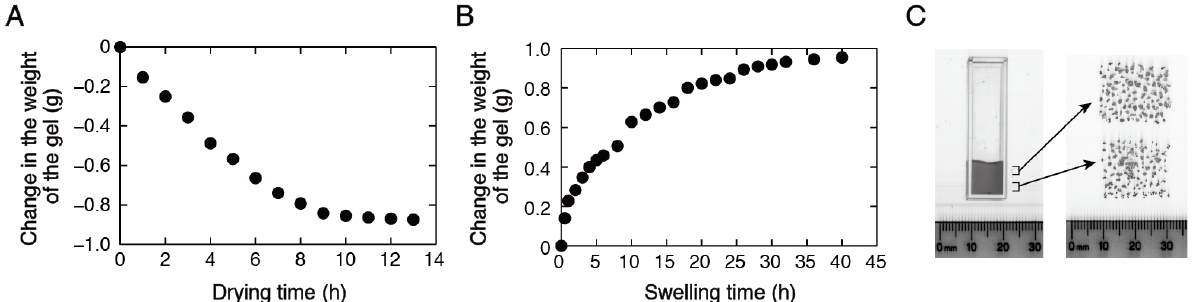
Figure 3. ( A ) The drying time-dependent change in the weight of the 10% polyacrylamide gel prepared with a 1 mL solution. ( B ) The swelling time-dependent change in the weight of the dried polyacrylamide gel. ( C ) Fluorescence images of fluorescent dye-labeled 10-mer HP in the 10% polyacrylamide gel prepared in a 10-mm cuvette (left) and crushed pieces of the upper and lower parts of the gel in the cuvette (right).